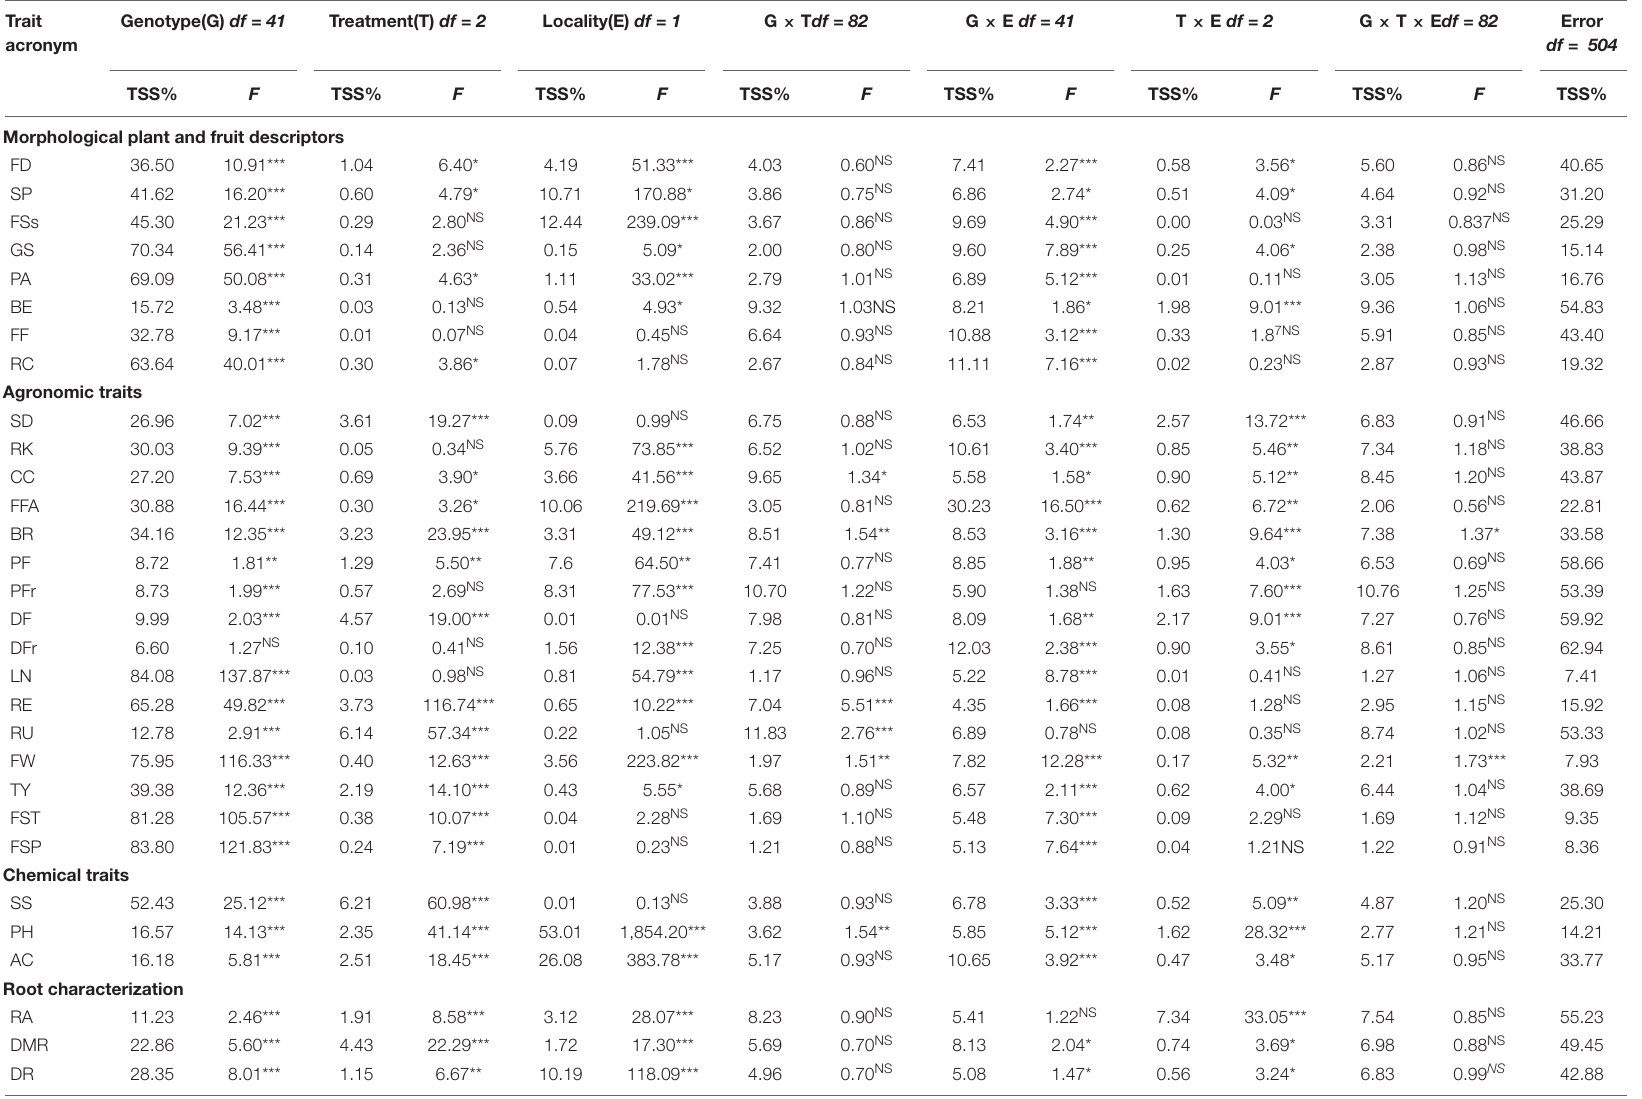
TABLE 5 | Multifactorial analysis and significant levels for genotype (G), environment (E), treatments (T), and combined effects (G × E, G × T, E × T, G × E × T) for pseudo qualitative and quantitative traits evaluated in this study on 42 tomato varieties grown under control, water stress (Etc30%, N100%), and nitrogen stress (Etc100%, N0) treatments in two locations (Italy and Spain). Trait